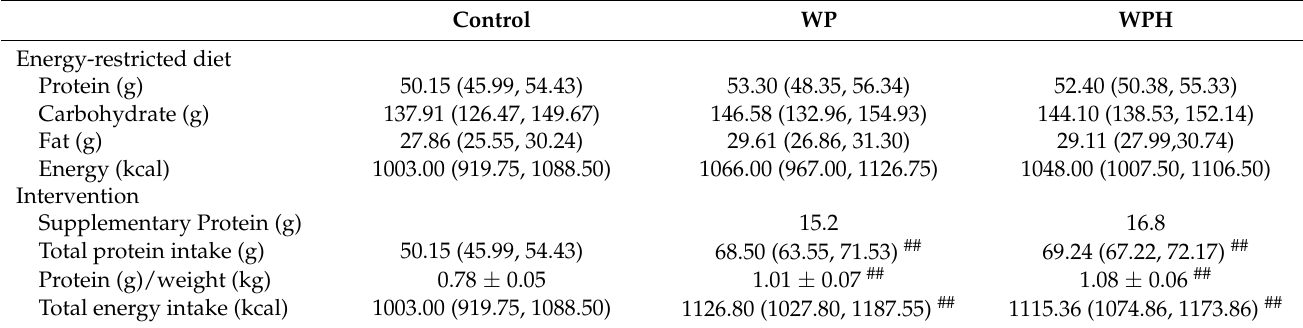
Table 2. The energy and macronutrient intake during the